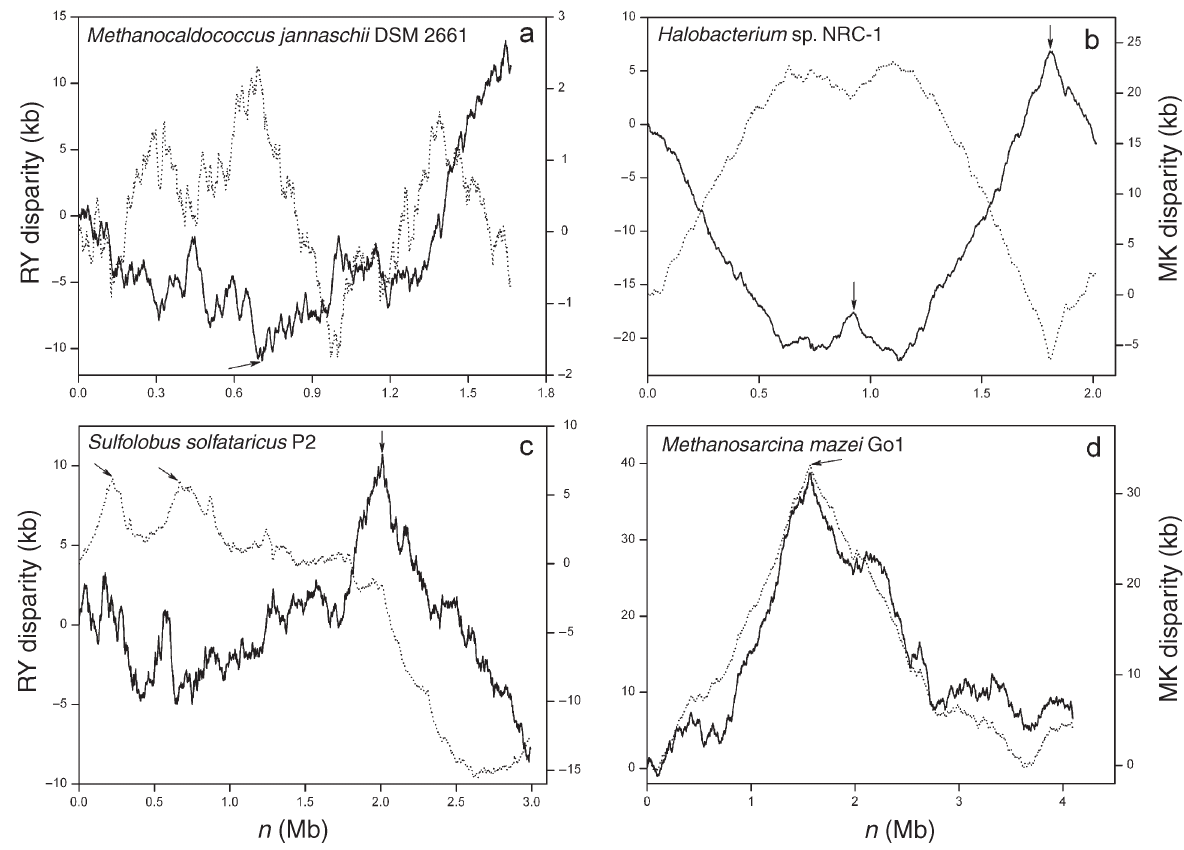
Figure 2. The Z -curves for the genomes of (a) Methanocaldococcus jannaschii DSM 2661, (b) Halobacterium sp. NRC-1, (c) Sulfolobus solfataricus P2 and (d) Methanosarcina mazei Go1. Unbroken lines denote RY disparitycurves, and broken lines denote MK disparitycurves. Ar- rows indicate the positions of cdc6 genes, which are also the positions of predicted replication origins. In the Halobacterium sp. NRC-1 genome, Berquist and DasSarma (2003) have identified a chromosomal autonomously replicating sequence element, which is at the location of the cdc6-3 (arrow at about 1.8 Mb). Robinson et al. (2004) have identified two replication origins in the S. solfataricus genome in vivo. The two replication origins, oriC1 and oriC2 , are close to cdc6-1 and cdc6-3 , respectively (the positions of the first and third